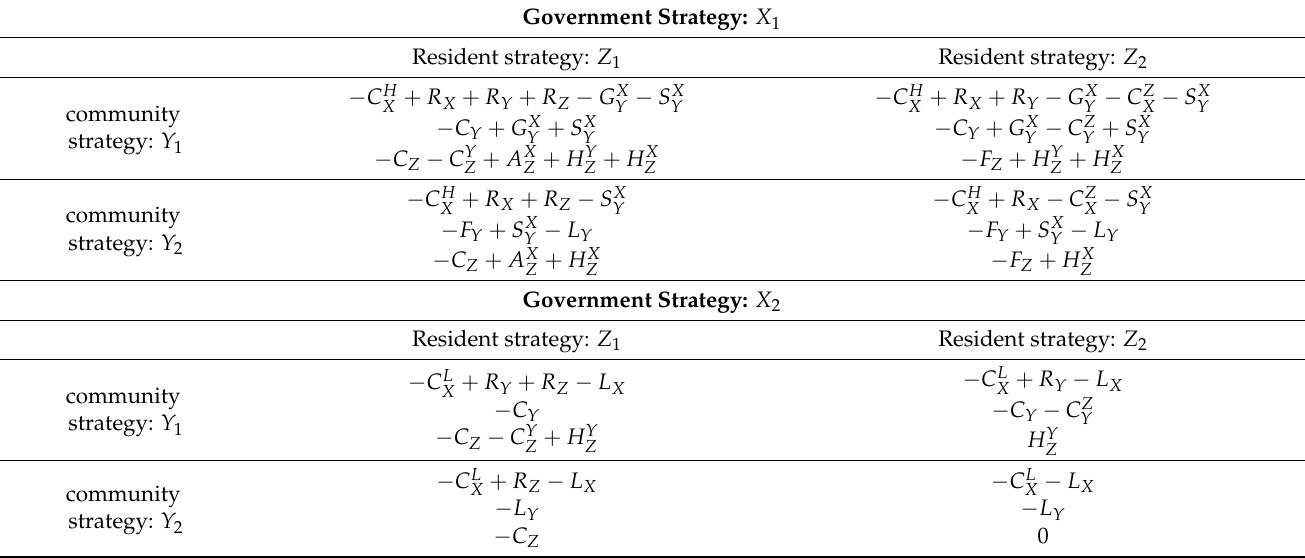
Table 2. Game payment matrix of government, community, and